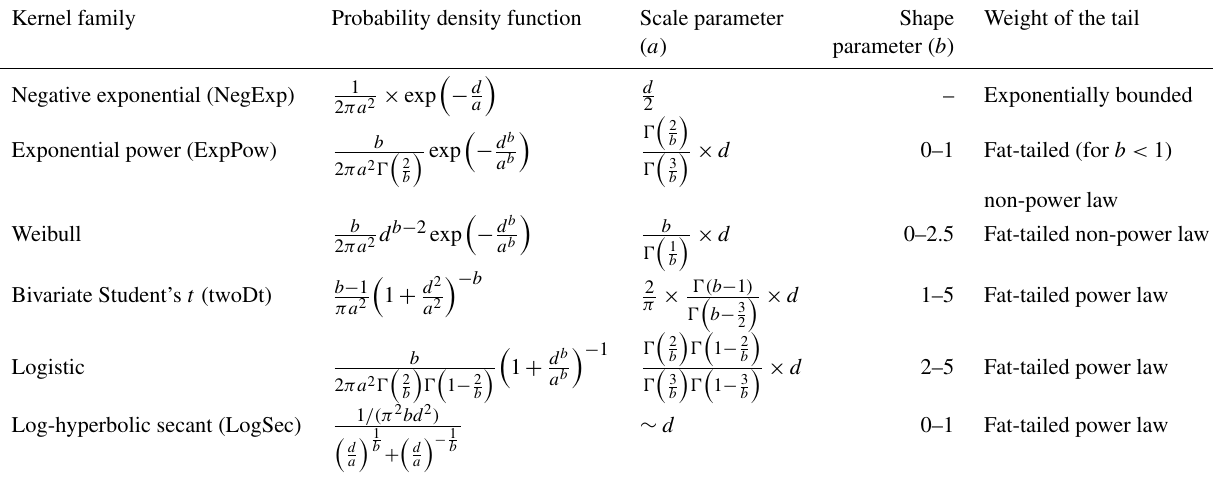
Table 3. Probability density functions (PDFs) for the default dispersal kernel in LPJ-GM (negative exponential) and five additional kernels. d : dispersal distance in metres (SDD d or LDD d ); a : scale parameter as a function of dispersal distance ( a 1 and a 2 for SDD d and LDD d , respectively, in Eq. A3); b : shape parameter range to search for better representation of LDD events. Range boundaries are defined by the values for which PDF are mathematically significant and the corresponding tail is fat (Nathan et al., 2012). Table adapted from Nathan et al. (2012) and Bullock et al. (2017). Gamma function: (cid:48)(n) = (n − 1 ) ! , where n is any positive integer. Kernel